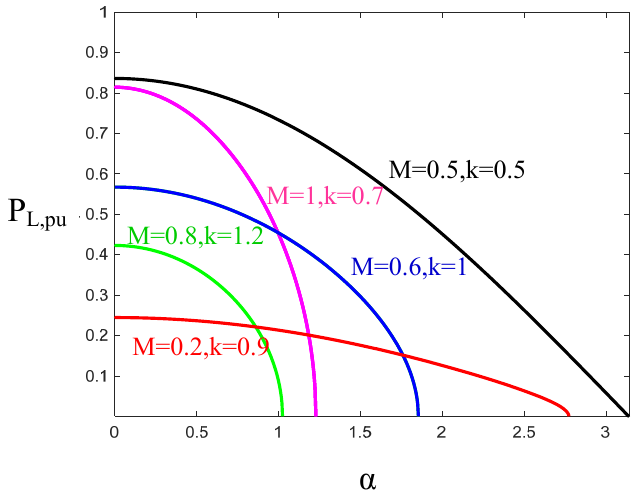
Figure 7. The variation ranges of P L , pu and α at different values of M and k